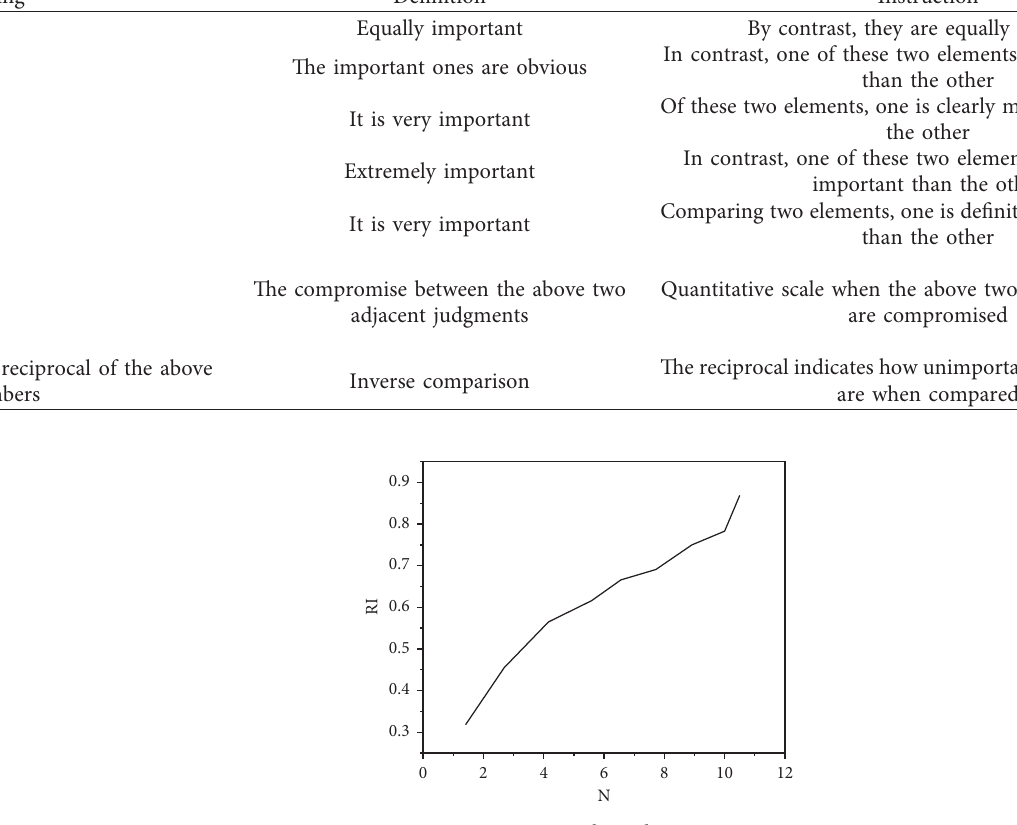
Figure 7: RI value